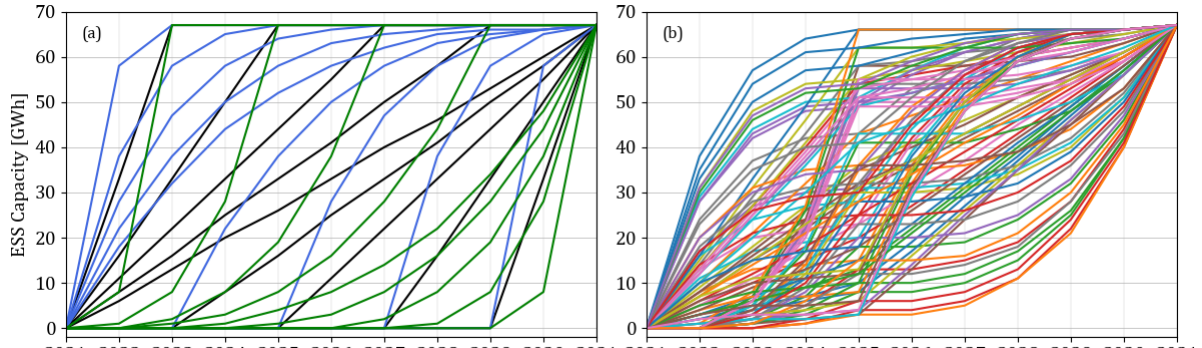
Figure 9. Sample growth trajectory generation using ( a ) manual generation to handle the extreme cases and ( b ) Monte Carlo random sampling to provide the random samples in the middle. ( a ) shows the filling process between planning years, where black, blue, and green represent linear, logarithmic, and exponential growth, respectively. ( b ) represents one of the planning hops (2021, 2025, 2031) and the filling process as shown in ( a